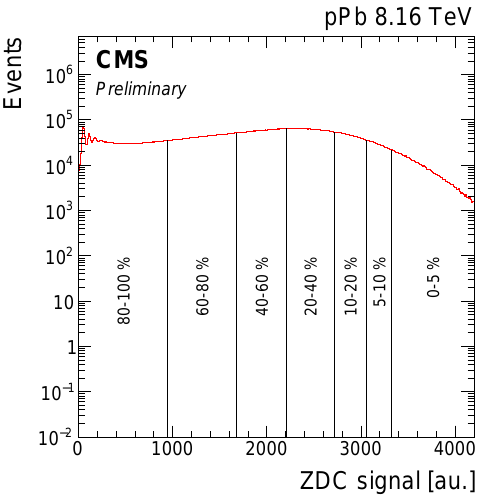
Figure 7. Centrality classes based on ZDC energy